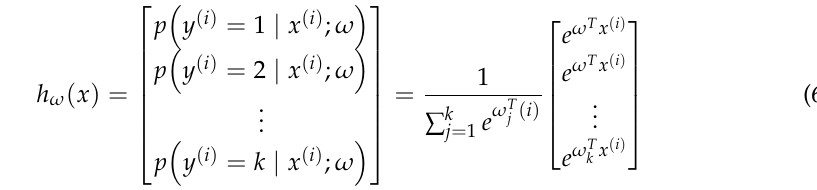
Figure 4. Informational route for fluorescent protein bright spot aggregation degree. ( a ) Image pre ‐ processing. ( b ) Bright spot information extraction and aggregation degree calculation.